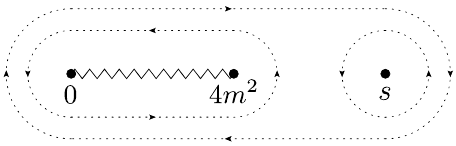
Figure 3 . Contours discussed for the two-mass non-elliptic